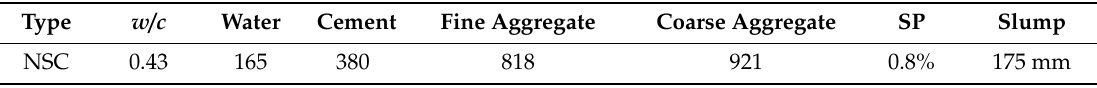
Table 1. Mixture proportion of NSC.